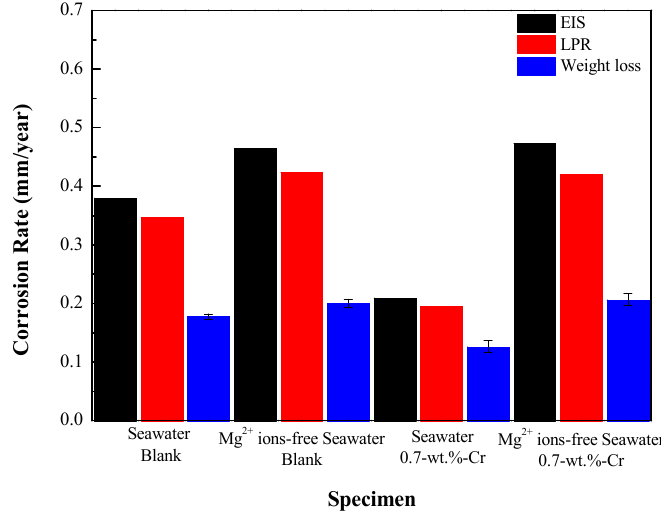
Figure 2. Corrosion rates of specimens, measured by electrochemical impedance spectroscopy (EIS), linear polarization resistance (LPR) and weight-loss measurements for 30 days.